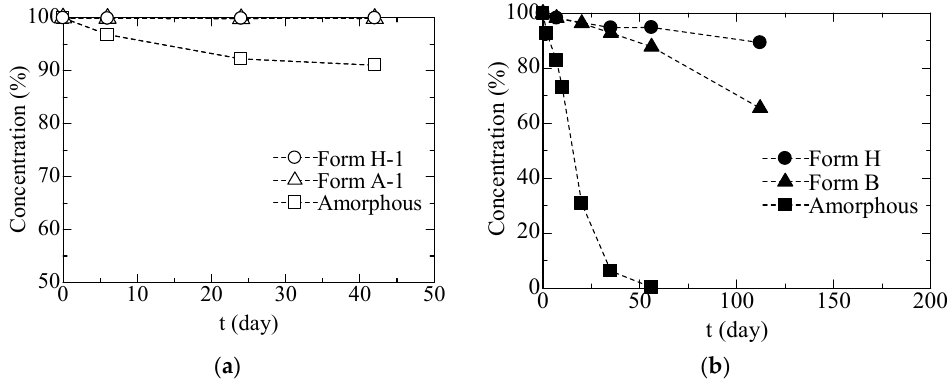
Figure 8. Stability of CS-023 in aqueous solution and 80 v/v % ethanol solution: ( a ) Dependence on initial concentration of CS-023, ( b ) Dependence on temperature. Figure 9a,b present the stability of solid CS-023 at 40 ◦ C under 0% RH and 75% RH, respectively. In Figure 9, the data for other polymorphs obtained later were also presented. The crystalline solid, Form H-1 was stable under 0% RH. The amorphous solid was degraded even at 0% RH and the degradation product was identified as a mixture of hydrolyzed CS-023 and a dimer of CS-023, as shown in Figure 10. Hydrolysis of the amorphous solid at 0% RH may be caused by water being tightly adsorbed on CS-023 powder. Form H was 10% degraded at 100 days under 75% RH. According to the chemical analysis of the degradation product, the degradation was hydrolysis at the β -lactam site. Amorphous powder of CS-023 was more quickly degraded under 75% RH, and the ratio of hydrolysis at the β -lactam site was 90%, with the other being a dimer.